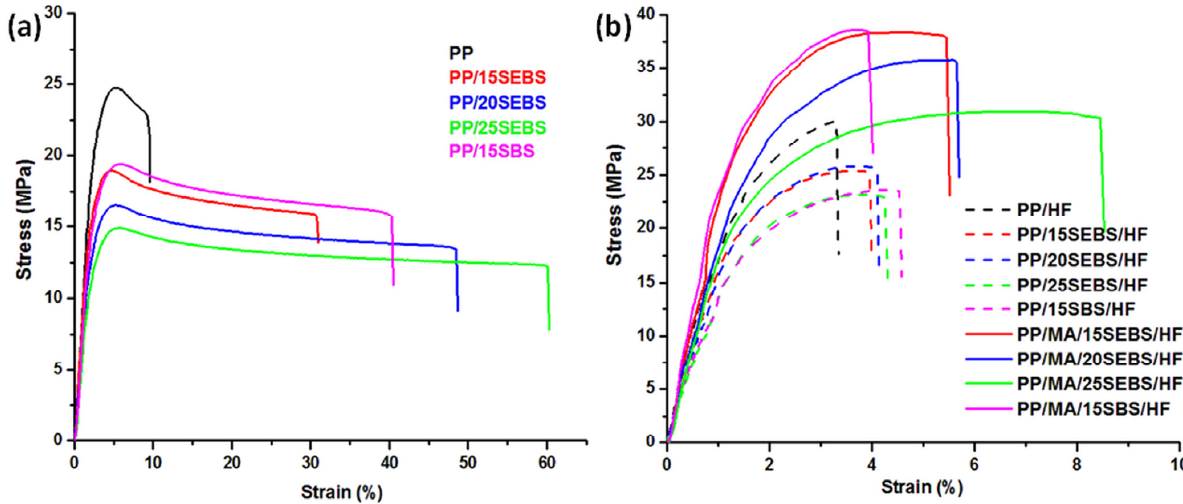
Figure 1. Stress–strain curves for the PP blends ( a ) and composites ( b ).